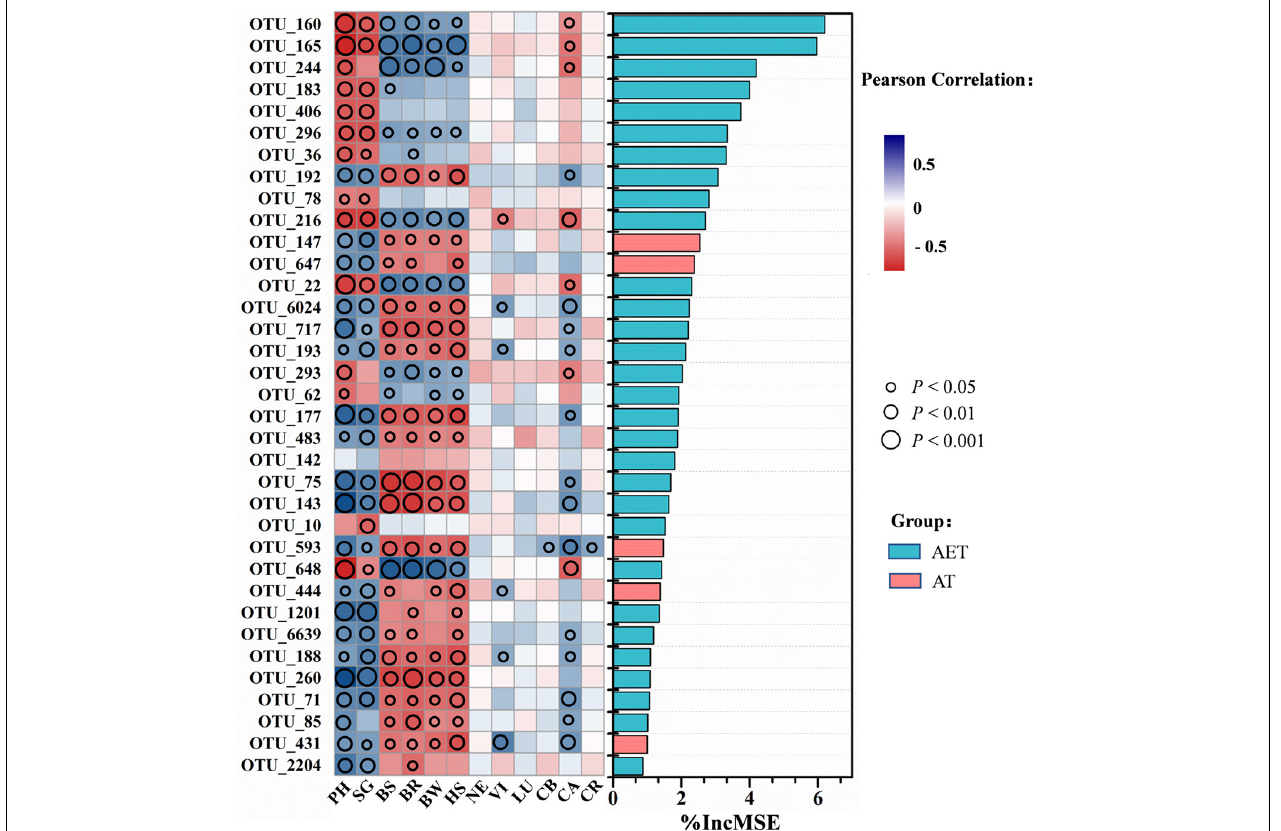
FIGURE 5 | Correlation and best random forest model for the relative abundance of top 35 most important taxa. For variable selection and estimating predictability, the random forest machine-learning algorithm was used. Circle size represents the p -value as a result of Pearson correlation analysis between taxa and plant growth traits including plant physiological growth status, disease morbidity, and pigment contents. Different colors represent Pearson correlations. Plant physiological growth status: PH, plant height; SG, stem girth. Disease morbidity: BS, black shank; BR, black root rot; BW, bacterial wilt; HS, hollow stalk. Leaf pigment contents: NE, neoxanthin; VI, violaxanthin; LU, lutein; CB, chlorophyll b; CA, chlorophyll a; CR,